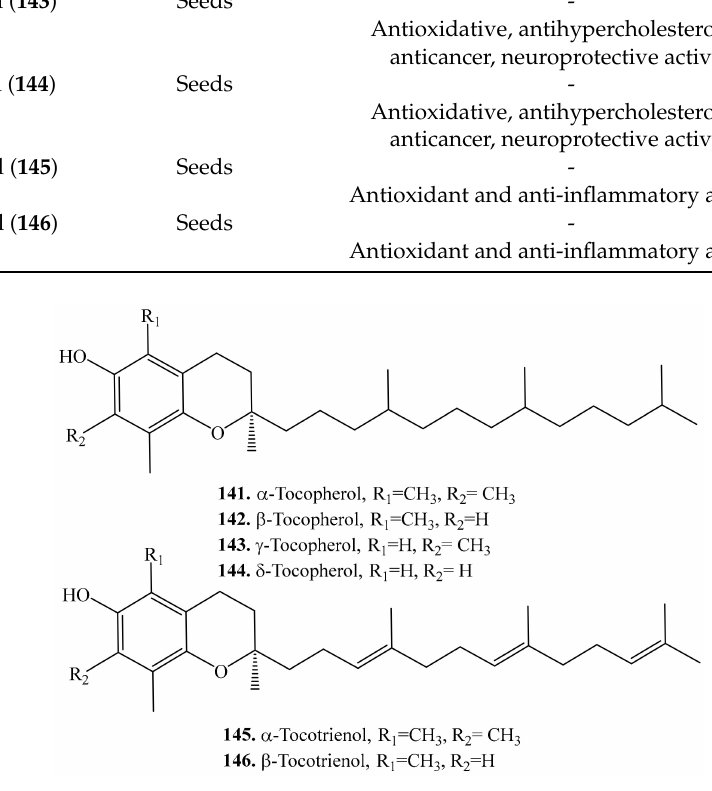
Figure 21. Structures of the meroterpenoids isolated from